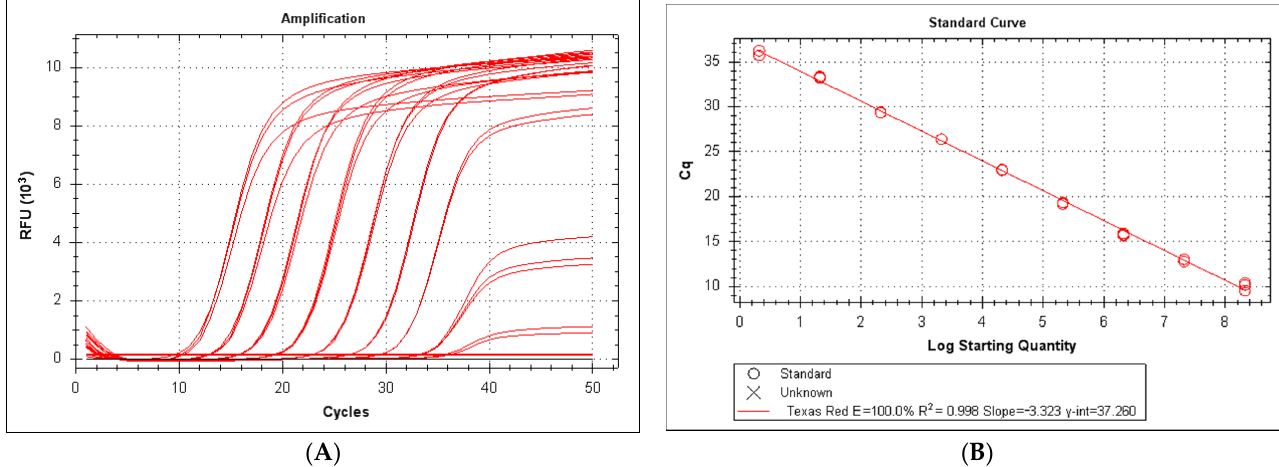
Figure 1. ( A ) Serial dilution from 2.1 × 10 8 to 2.1 copies per reaction. Black lines correspond to negative Scheme 2. 1 × 10 − 1 and 2.1 × 10 − 2 copies per reaction). ( B ) Standard curve from 2.1 × 10 8 to 2.1 copies per reaction.